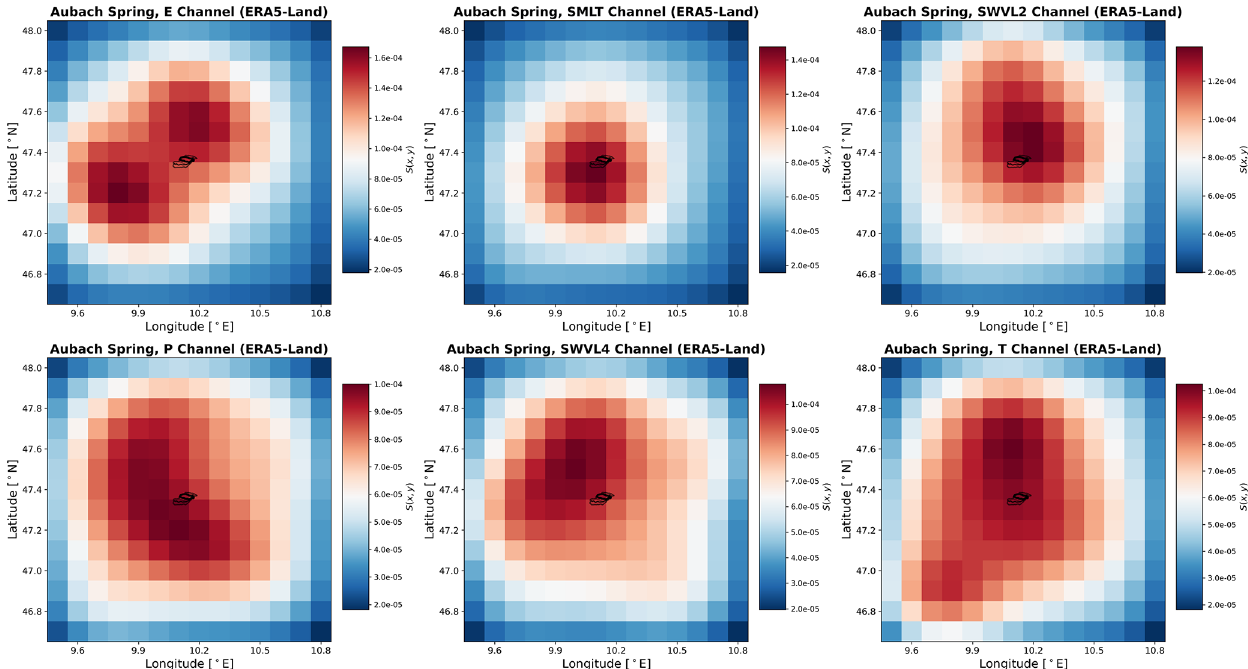
Figure C1. Spatial input sensitivity heat maps for Aubach spring based on ERA5-Land gridded